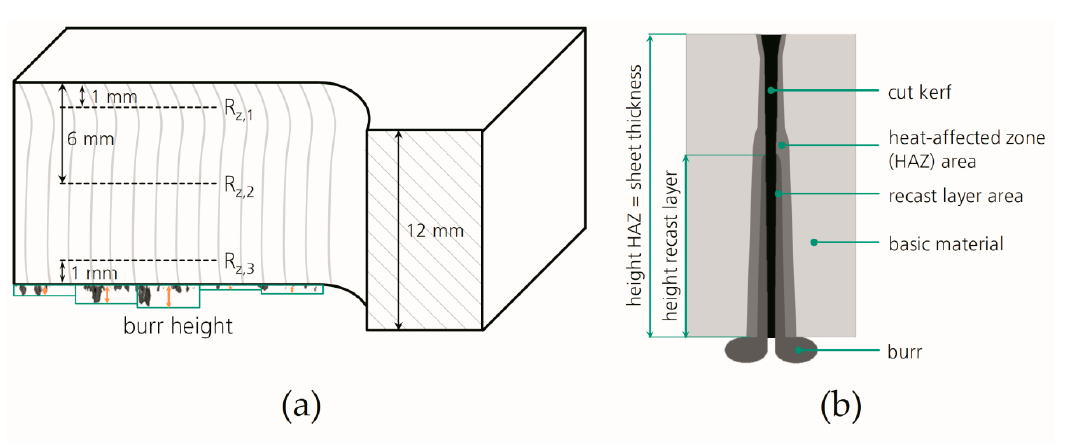
Figure 2. Characterization methods: ( a ) Cross-sectional view along the cutting direction verifies the cut edge quality: maximum burr height was detected in five sections, surface roughness R z was measured along three lines; ( b ) Cross-sectional view across the cutting direction investigates the laser beam energy deposition: heat affected zone (HAZ) and recast layer were studied as area measurements and the height of the recast layer was recorded.